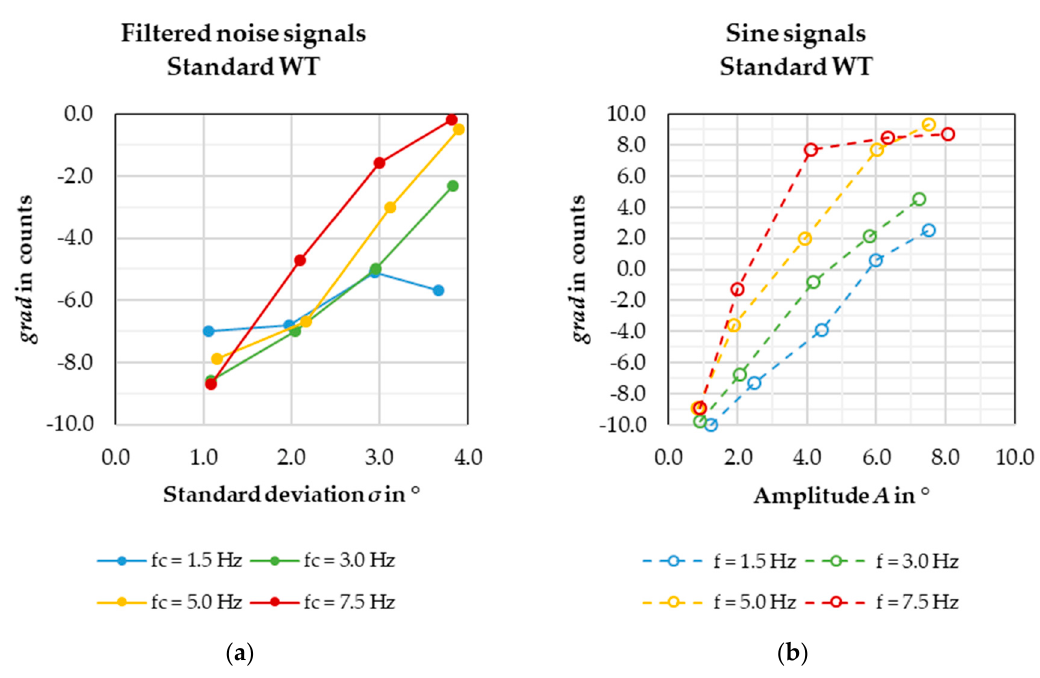
Figure 7. ( a ) Pressure gradients in the empty test section for the filtered noise signals, in the standard wind tunnel configuration; ( b ) Pressure gradients for the sine signals under the same conditions.